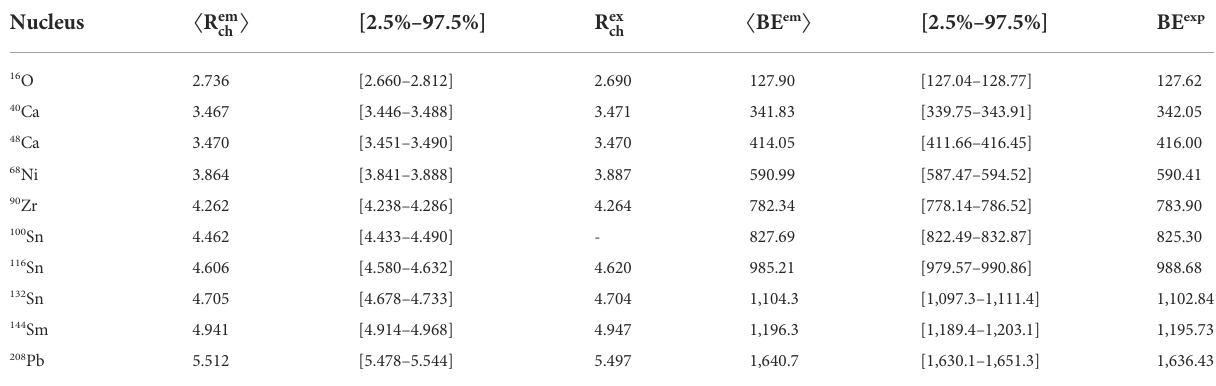
TABLE 3 Mean values and 95% credible intervals of the Bayesian posteriors on charge radii (in fm) and binding energy (in MeV), showed in Figure 6. Also displayed are the 19 available experimental values [60, 63]. The credible intervals are calculated as equal-tailed intervals — such that the probabilities of falling above or below the interval are both equal to